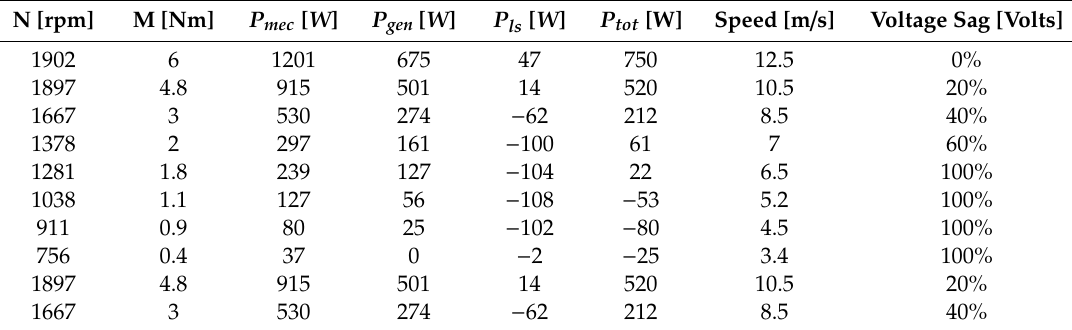
Table 2. Experimental Data Captured.